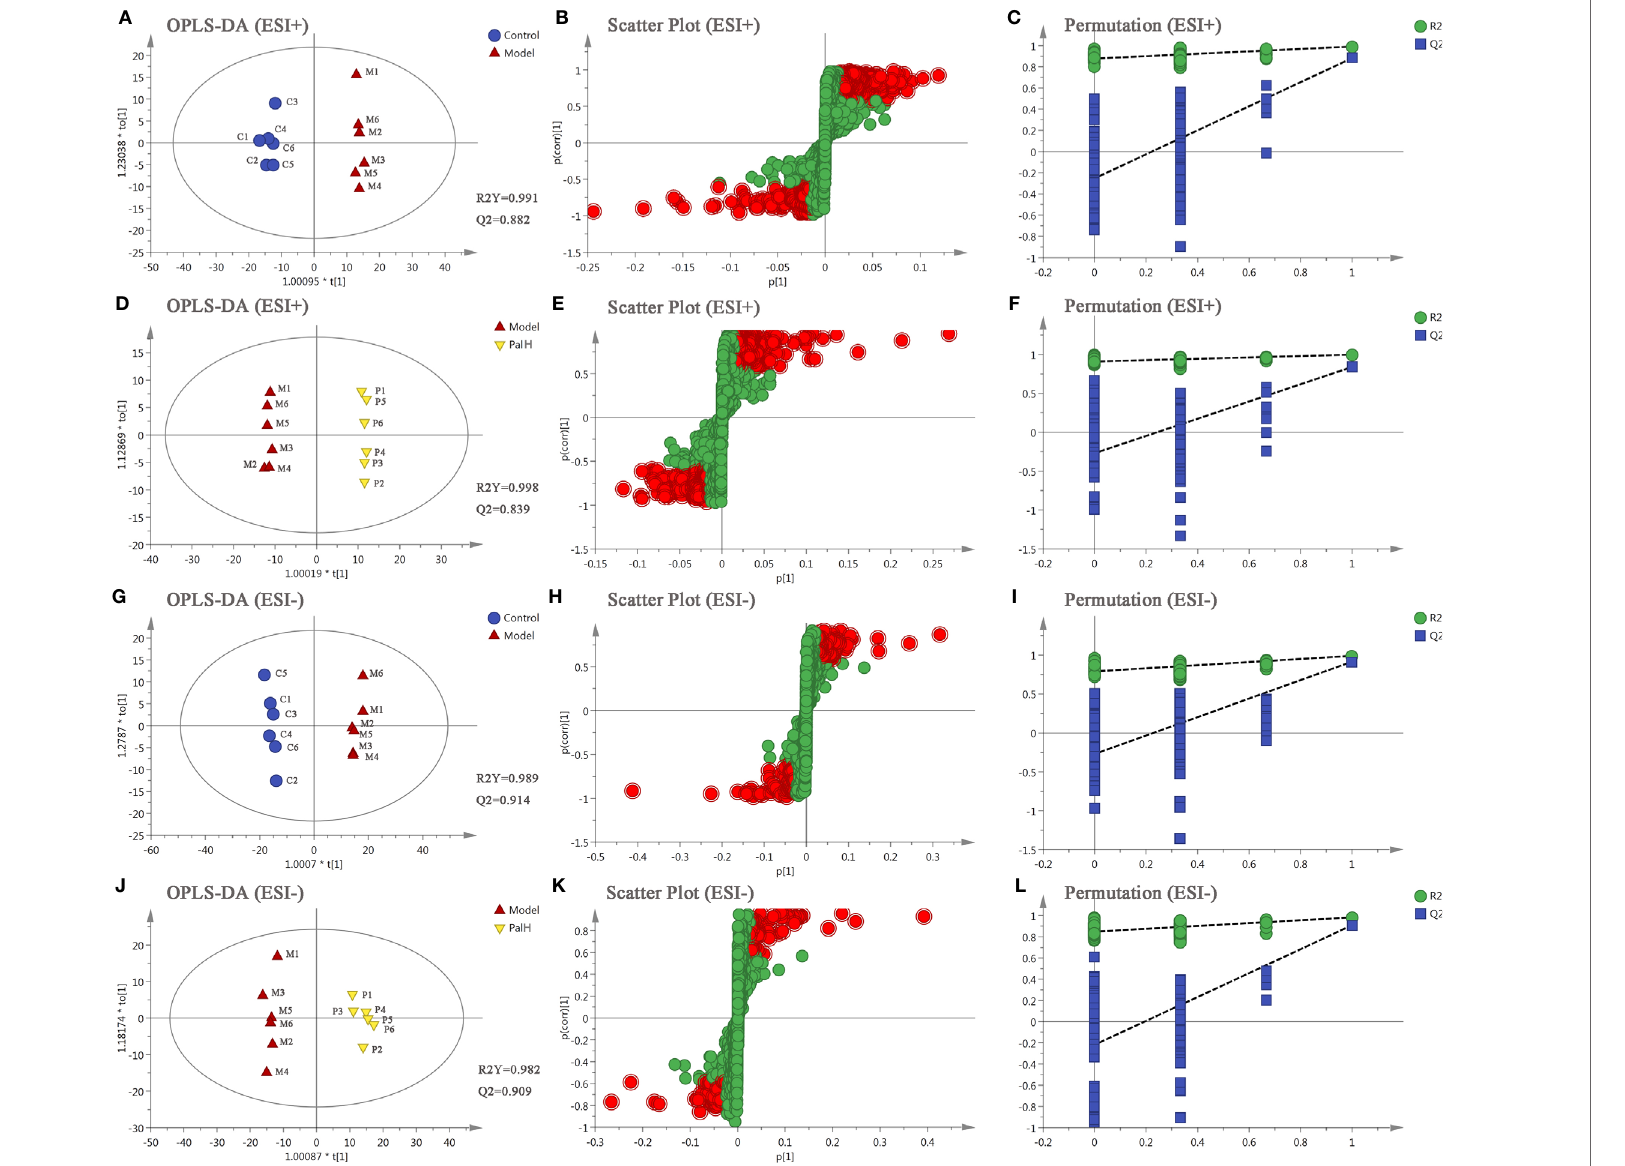
FIGURE 10 | The orthogonal-partial least squares-discriminant analysis (OPLS-DA) score plots, S-plots and 100-permutation test of serum metabolomics analysis. (A – F) ESI+ model. (G – L) ESI- model. PalH: (40